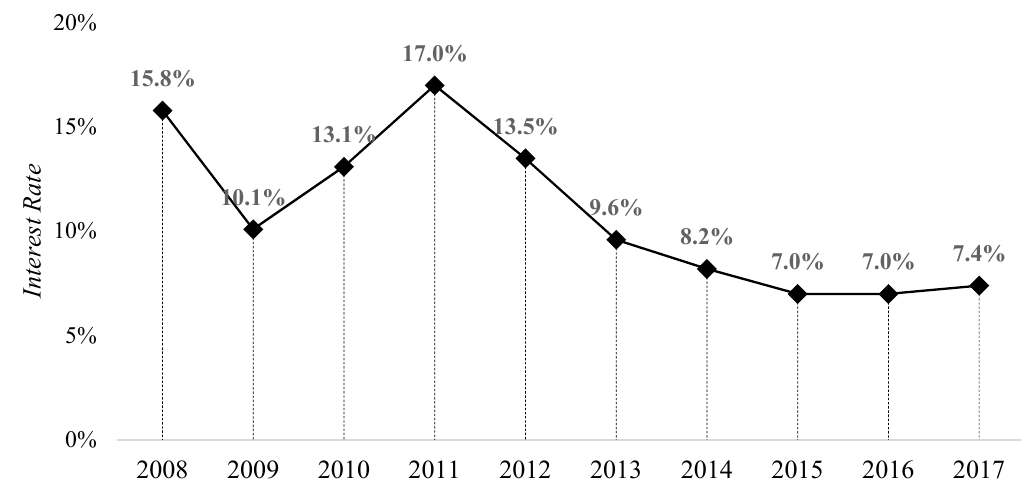
Figure 1. Lending Interest Rate of Vietnam 2008–2017. Source: World Bank.